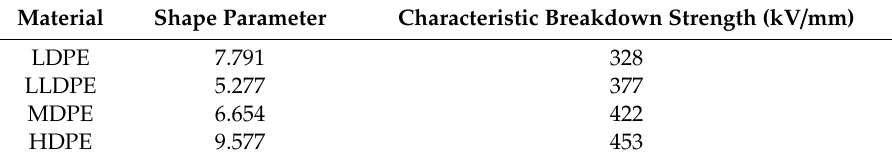
Table 2. Shape Parameter and Breakdown Strength of